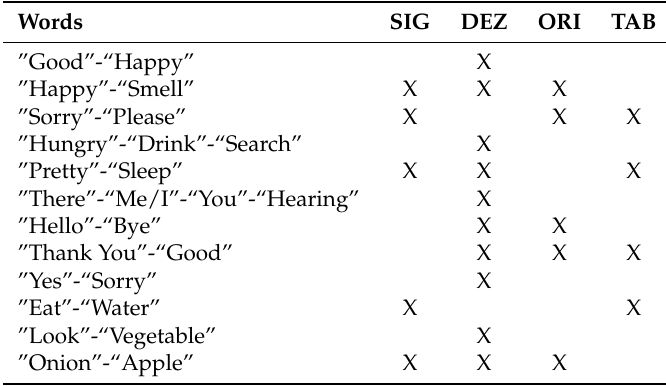
Table 1. A list of chosen ASL words indicated by their